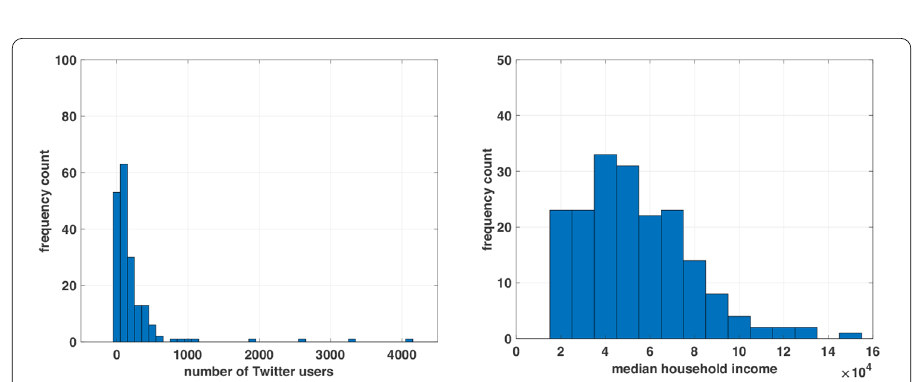
Figure 10 Histograms of (Left) the number of Twitter users, and (Right) the median household income, for neighborhoods in the Northern American metropolitan